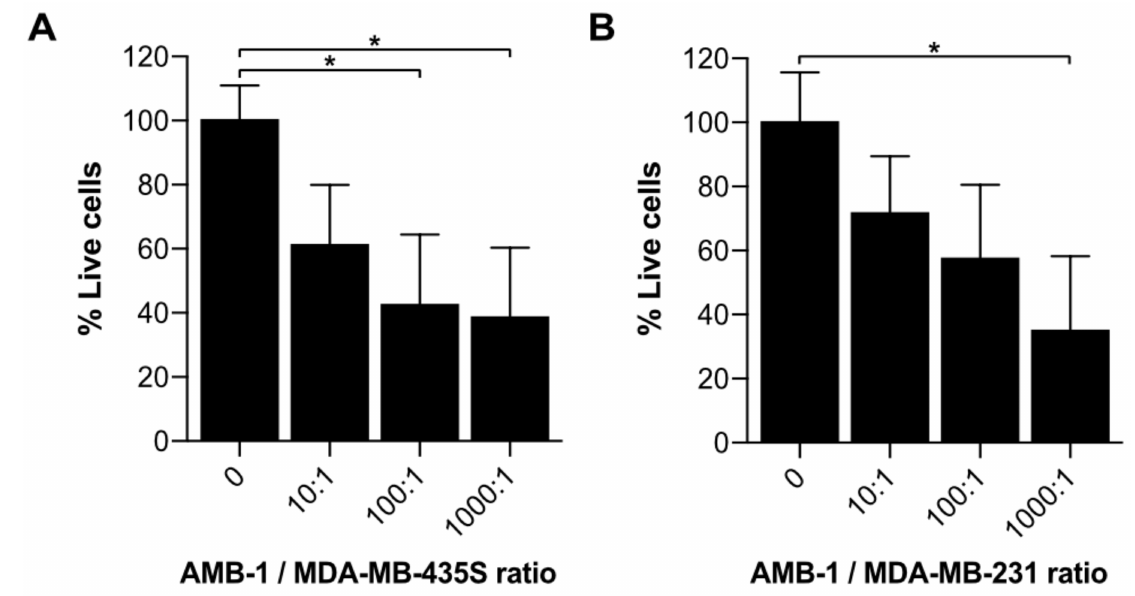
Figure 3. Investigation of cell growth upon incubation with AMB-1 bacteria. Cell viability of ( A ) MDA-MB-435S and ( B ) MDA-MB-231 was determined using an MTT assay and expressed as a percentage of the untreated cells. Viability (%) is expressed as mean ± SD of 3 individual biological replicates. Ordinary one-way ANOVA test was used to assess statistical significance (* p -value <